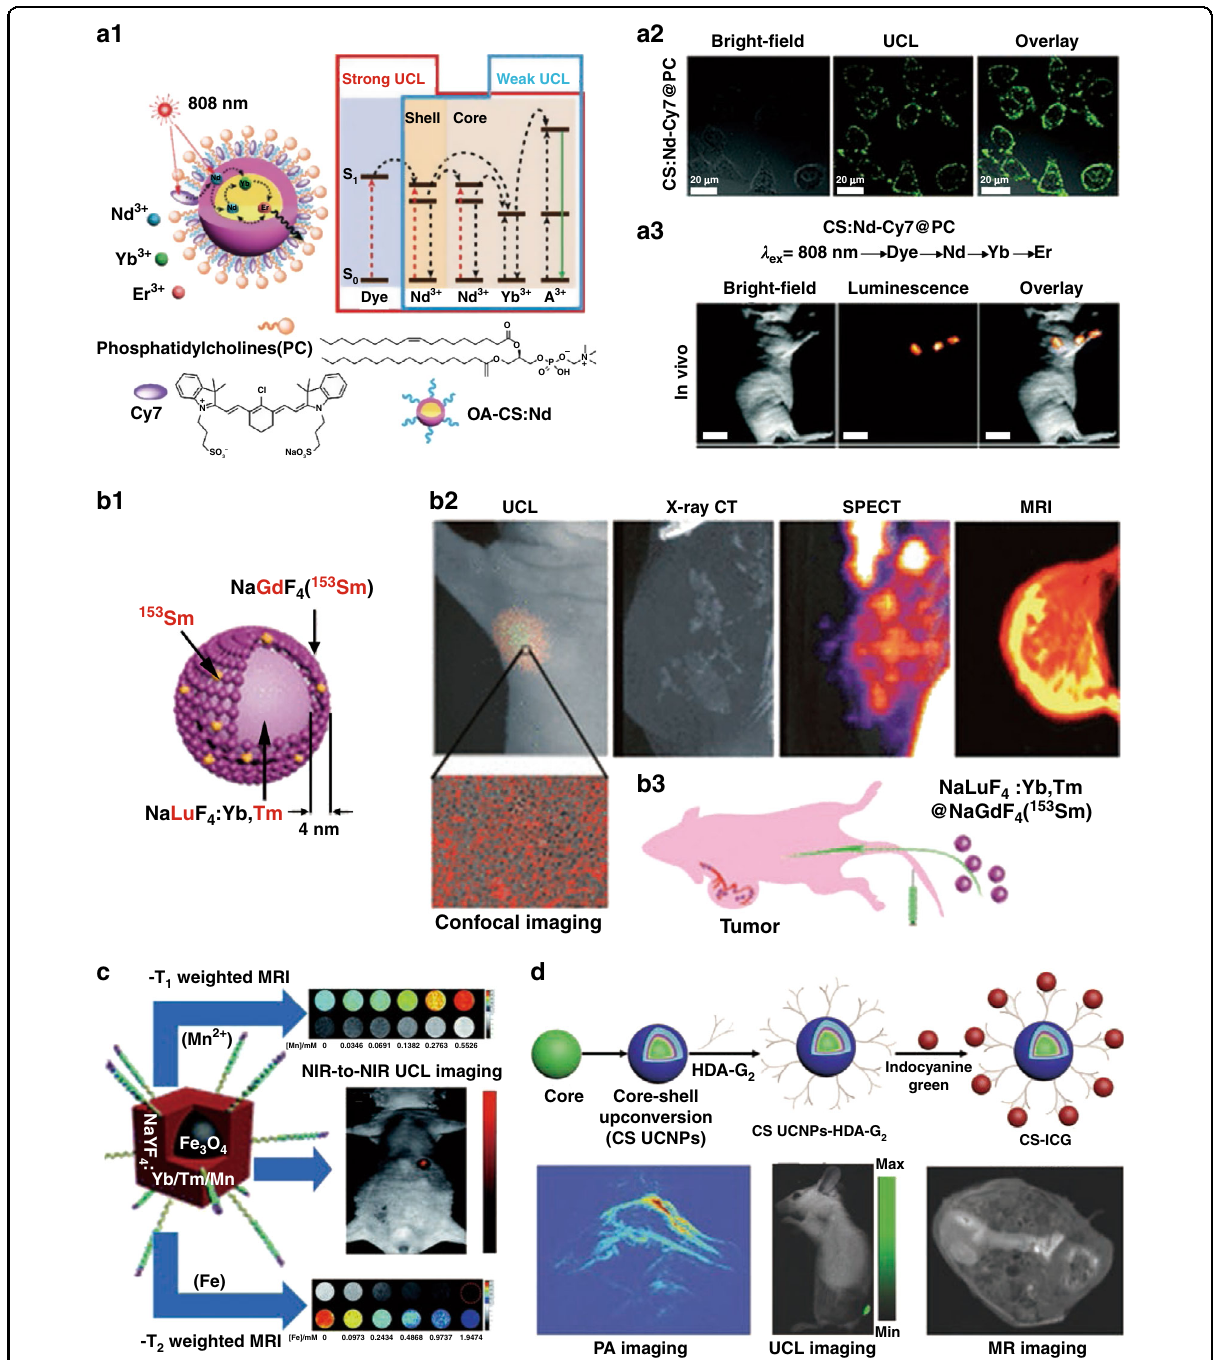
Fig. 5 Bioimaging. a1 Schematic diagram and energy level diagram of PC modi fi ed dye-sensitized UCNPs-based nanocomposite for photon upconversion upon 808 nm irradiation. a2 UCL images of HeLa cells incubated with CS:Nd-Cy7@PC. a3 UCL lymphatic imaging 30 min after injection of CS:Nd-Cy7@PC under 808 nm excitation 70 . b1 Composition of NaLuF 4 :Yb,Tm@NaGdF 4 ( 153 Sm). b2 Four-modal imaging of the tumor-bearing nude mouse at 1 h post intravenous injection of NaLuF 4 :Yb,Tm@NaGdF 4 ( 153 Sm). b3 Schematic diagram of tumor angiogenesis imaging using NaLuF 4 :Yb,